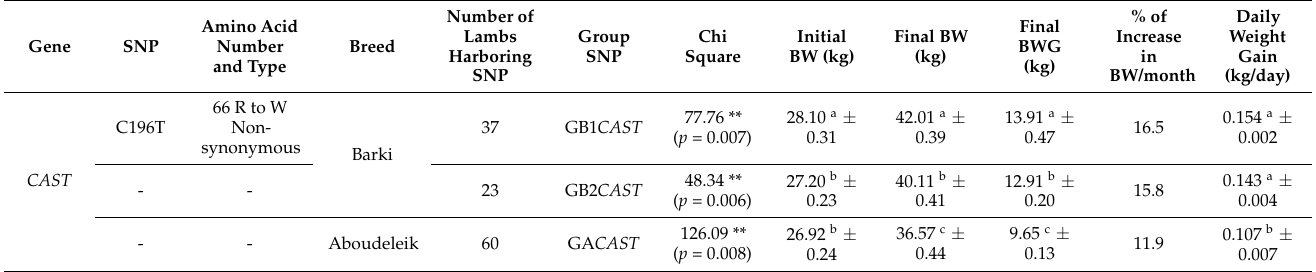
Table 4. Distribution of SNPs, type of mutation in growth-related genes and their association with growth performance in Barki and Aboudeleik lambs from the third to the sixth month of